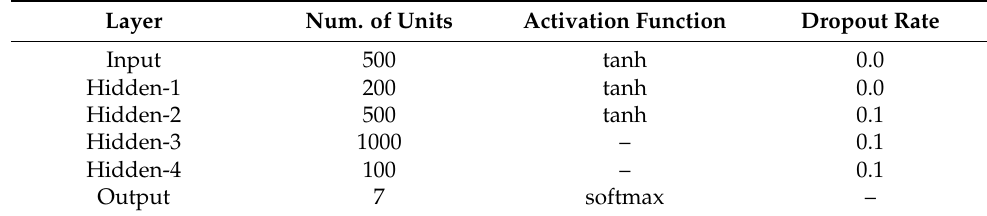
Table 6. Network structure and hyper parameters (Model-2).